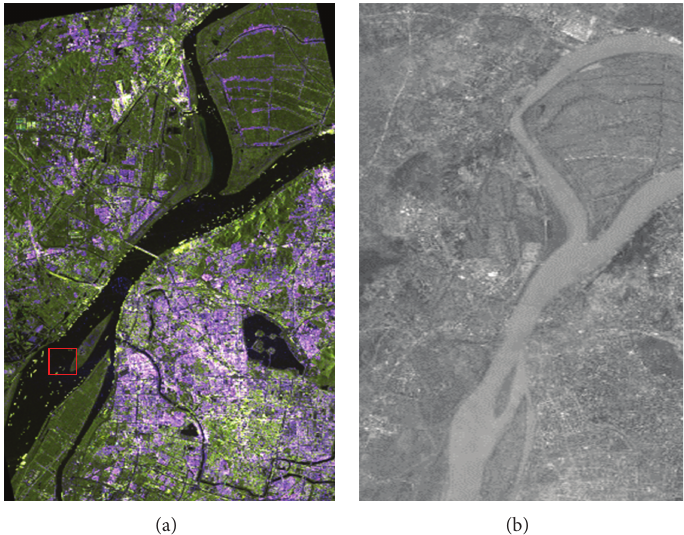
Figure 1: The image of Nanjing: (a) TerraSAR-X image; (b) SPOT5 optical image.